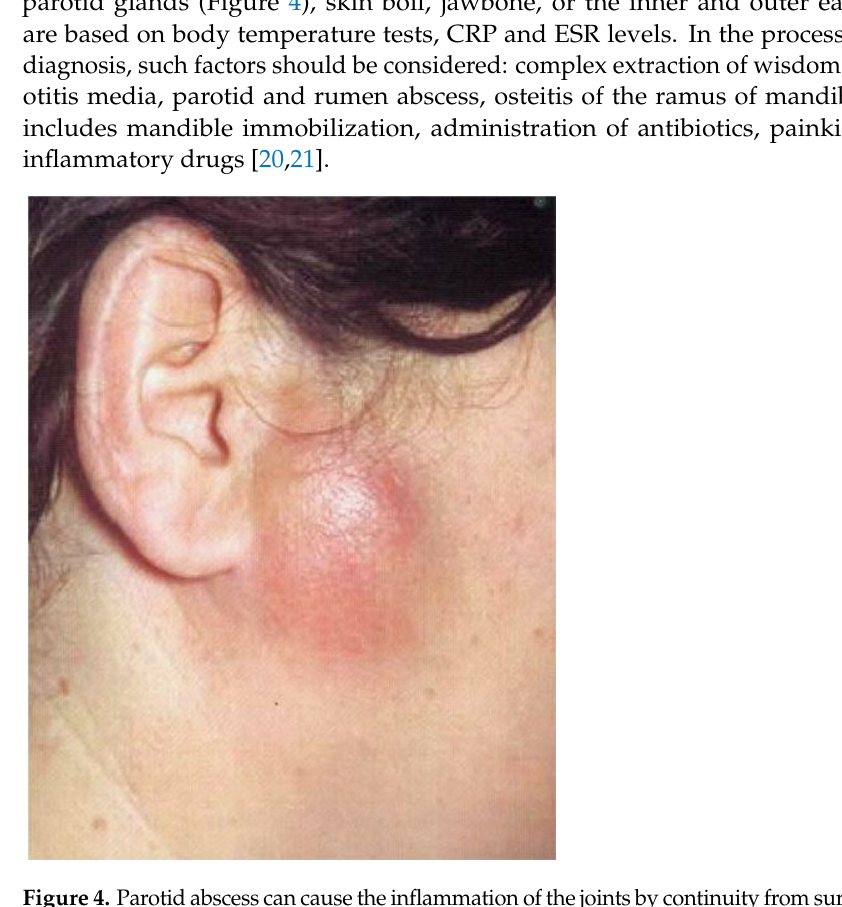
Figure 4. Parotid abscess can cause the inflammation of the joints by continuity from surrounding